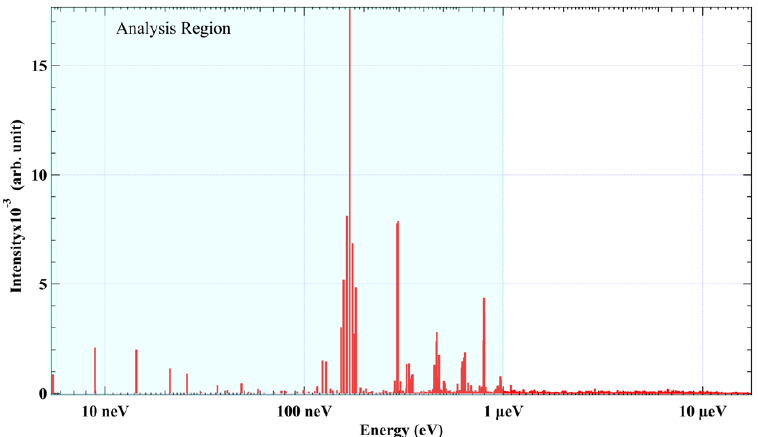
Figure 4. Spectral lines of hematite after MEM conversion.